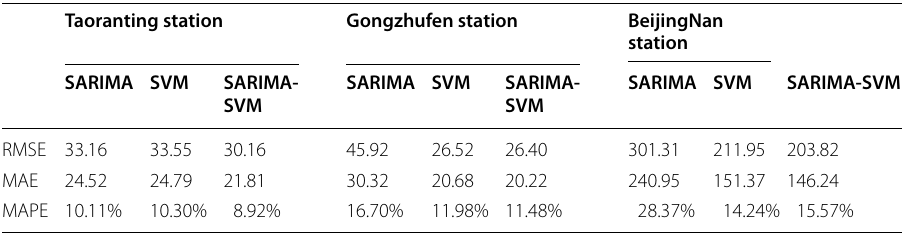
Table 4 Performance evaluation comparison of